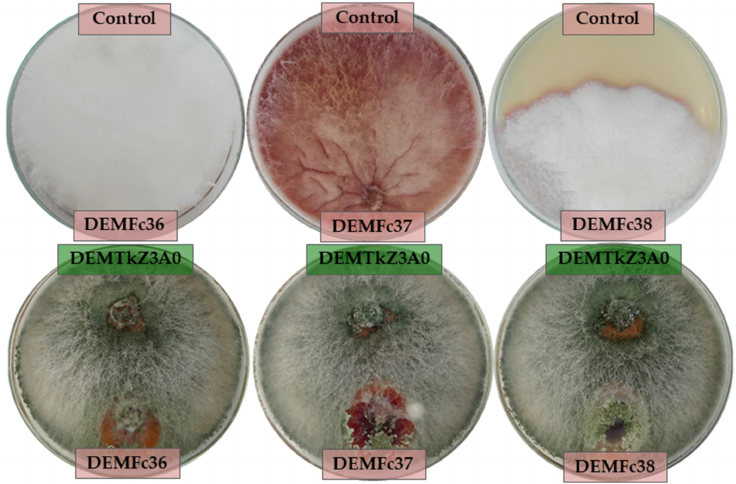
Figure 3. The macrographs of positive biotic effect of Trichoderma DEMTkZ3A0 strain in the interaction with phytopathogenic Fusarium spp. strains: F. graminearum DEMFc36, F. culmorum DEMFc37, and F. oxysporum DEMFc38 in comparison to the control on PDA medium, after 14 days of incubation at 20 ◦